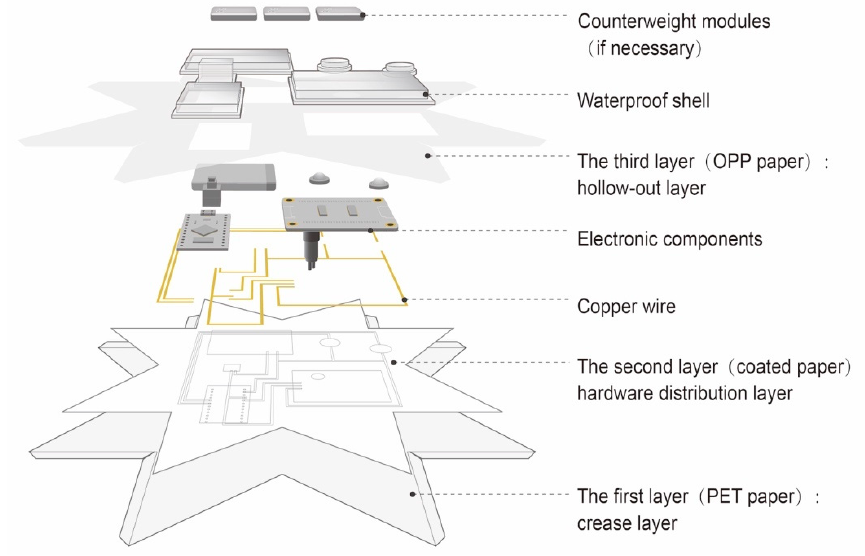
Figure 3. Multilayer structure of the paper ‐ based electronic interface.